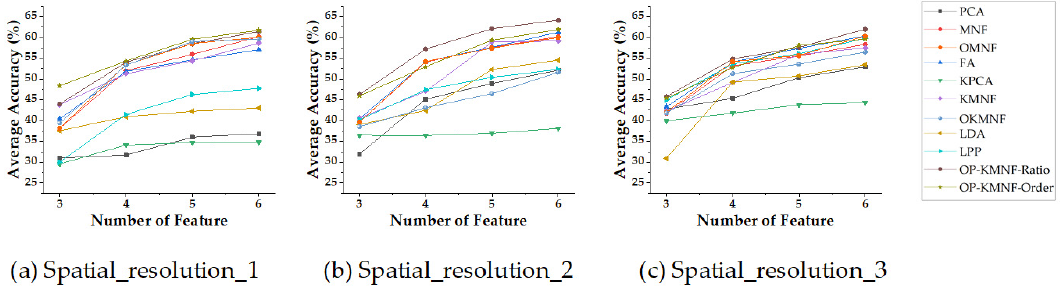
Figure 12. Comparison of the average accuracies of SVM classification on ( a ) Spatial_resolution_1, ( b ) Spatial_resolution_2, and ( c ) Spatial_resolution_3 after using different DR methods.